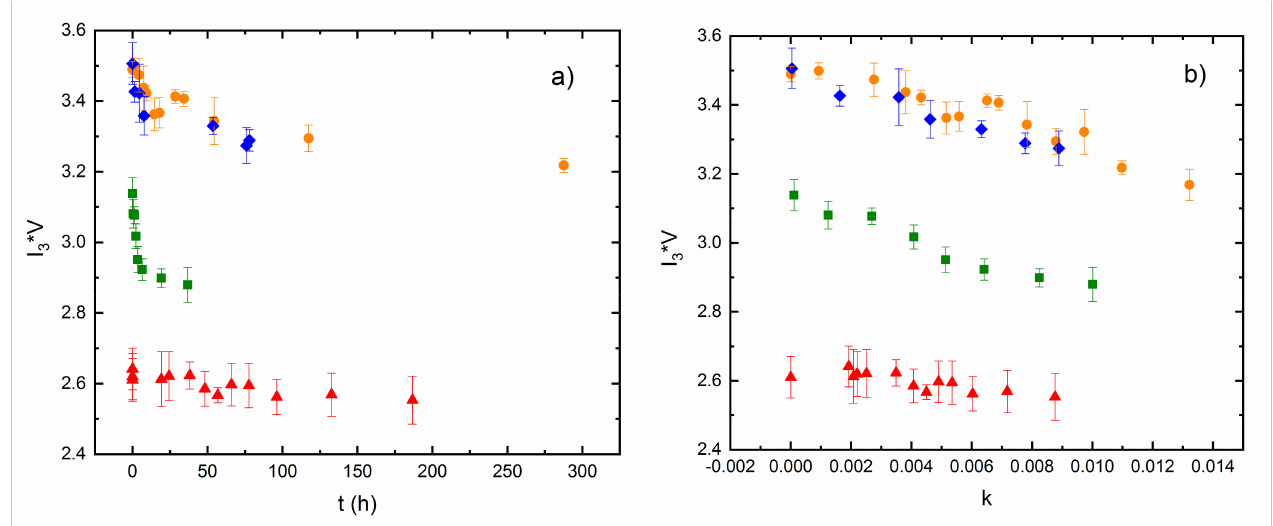
Figure 11. The reduced free volume fraction fv / C for the investigated samples as a function of time at swelling (reconstructed) ( a ) and as a function of water content expressed by k ( b ) AESO/VDM squares, AESO/VDM/DMPA triangles, ELO/PI dots, and ELO/10RD1/PI